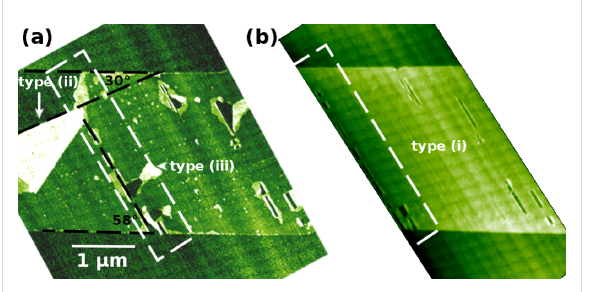
Figure 3: Tapping mode AFM image (a) of an exfoliated SLG flake on 6H-SiC(0001) showing examples of rupture and folding by the use of SHI, type (i), modification by AFM tip contacting and linescanning (ii), and severe heating (iii). Tapping mode AFM image (b) showing the modifications of SLG solely due to SHI irradiation, type (i), namely fold- ings aligned with the ion track. The dashed box in Figure 3(a) exhibit- ing modifications of type (ii) and (iii) added later, corresponds to the dashed box in Figure 3(b) prior to post-preparation